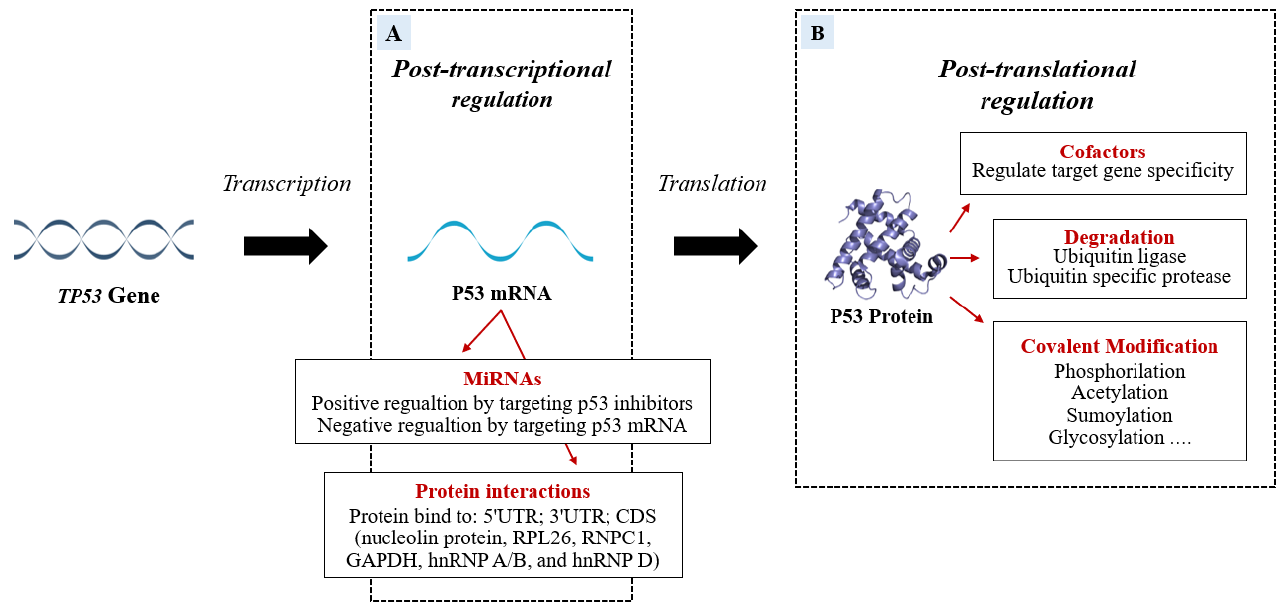
Figure 3. The P53 mRNA can be regulated post-transcriptionally ( A ) by miRNAs and RNA-binding proteins (RBPs) which modify the P53 transcriptional program in a stimulus-specific manner. The P53 miRNA regulation can be positive if miRNAs bind P53 inhibitors or can be negative if the miRNAs target is P53 mRNA. In addition to miRNA action, the P53 post-transcriptional program is also co-regulated, both negatively and positively, by RBPs that bind 5′UTR; 3′UTR; CDS of TP53 . Some proteins modify P53 post-translationally. The figure ( B ) shows the P53-modifications of specific amino acid residues divided into Covalent Modification, Ubiquitination, and cofactors.